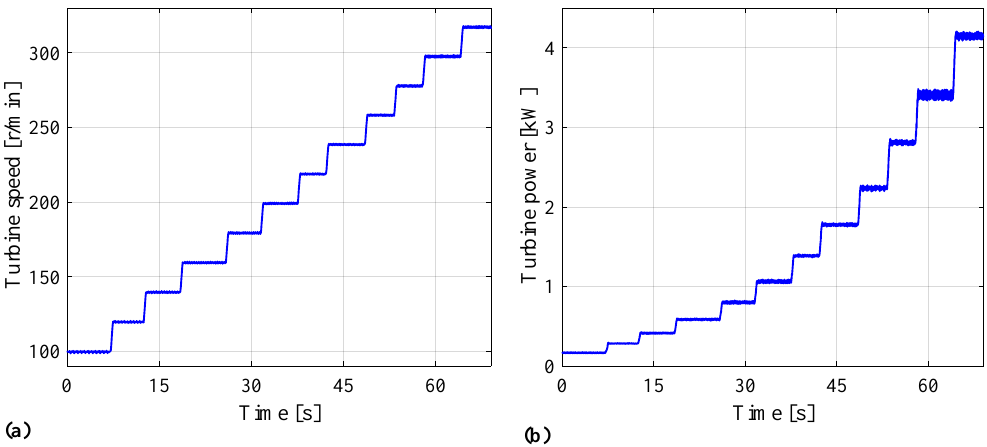
Figure 24. Measured ( a ) various turbine speeds and ( b ) turbine power responses versus time.